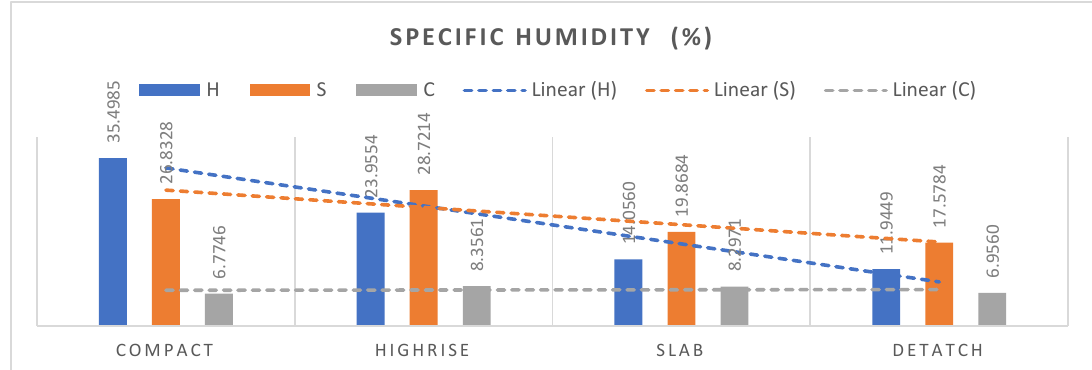
Fig. 16: Comparison of average specific humidity from simulation performed on the hottest, coldest and sultriest days of the year between four selected morphotypes